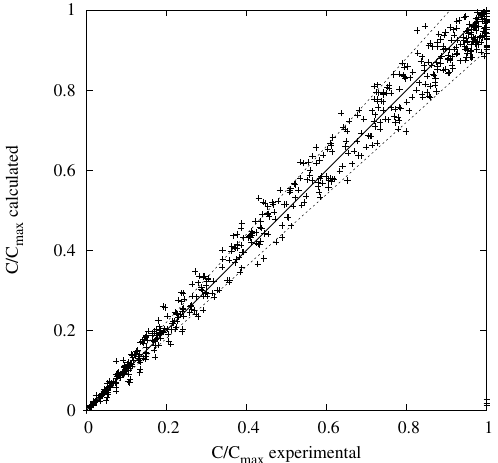
Figure 4. Parity plot between modeled and experimental normalized concentrations ( ±